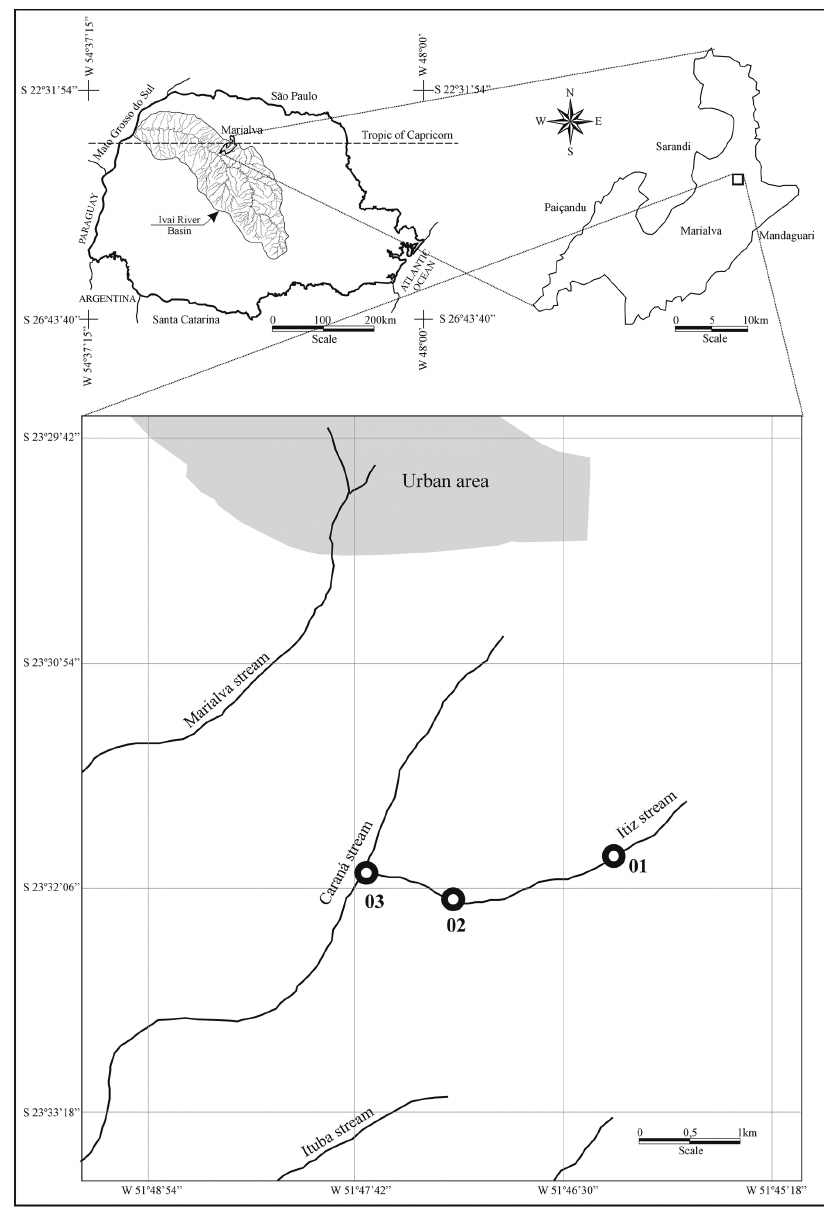
Figure 1. Map of Itiz stream in the Ivaí River basin, state of Paraná, Brazil, indicating sampling stretch (01= headwater, 02= middle and 03=